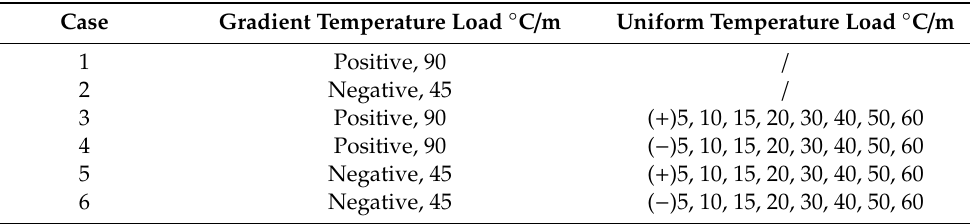
Table 6. Details of temperature loads for di ff erent simulated